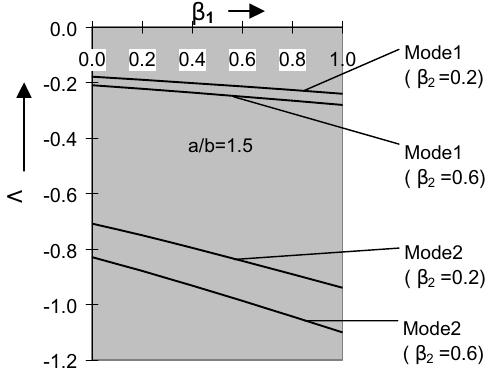
Fig. 1. Logarithmic decrement Λ vs taper constant β 1 for a clamped visco-elastic rectangular